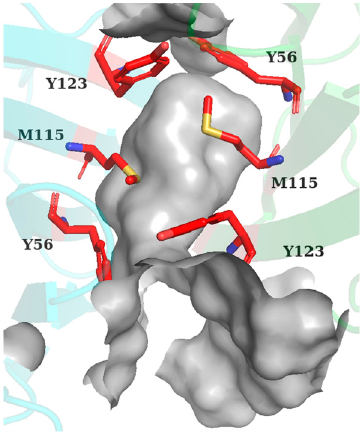
Figure 6. Spatial residue distribution of BMS-202 system. The distribution of key residues (red) was almost axisymmetric (similar distributions of these residues could also be found in other PD-L1 dimer/inhibitor systems). A PD-L1 and B PD-L1 are colored in green and cyan, respectively. Top view of the binding pocket, and the surface of pocket are colored in gray.